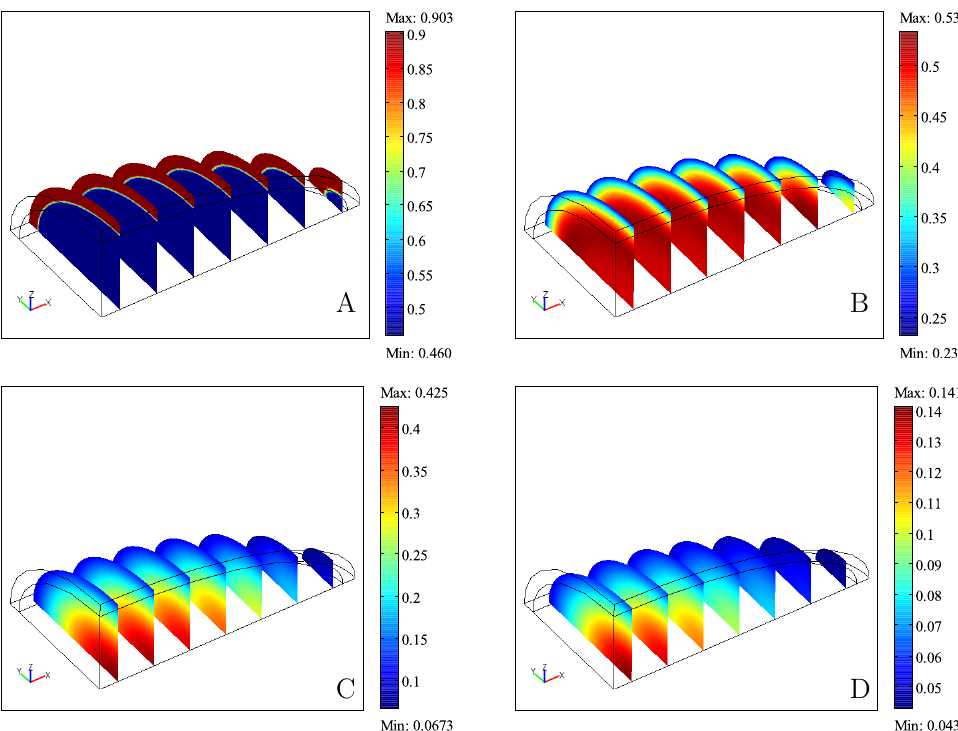
Figure 15. Evolution of the water volume fraction φ ( (cid:101) x , t ) inside the shrinking bean (shell and core) for decreasing values of the rescaled total moisture content X ( t ) / X 0 , T = 60 ◦ C, v = 0.6 m/s, D = 3.12 × 10 − 10 m 2 /s, Bi m = 12.87, α 0 = 0.39. ( A ) X ( t ) / X 0 = 1 (initial time instant); ( B ) X ( t ) / X 0 = 0.7; ( C ) X ( t ) / X 0 = 0.3; ( D ) X ( t ) / X 0 =